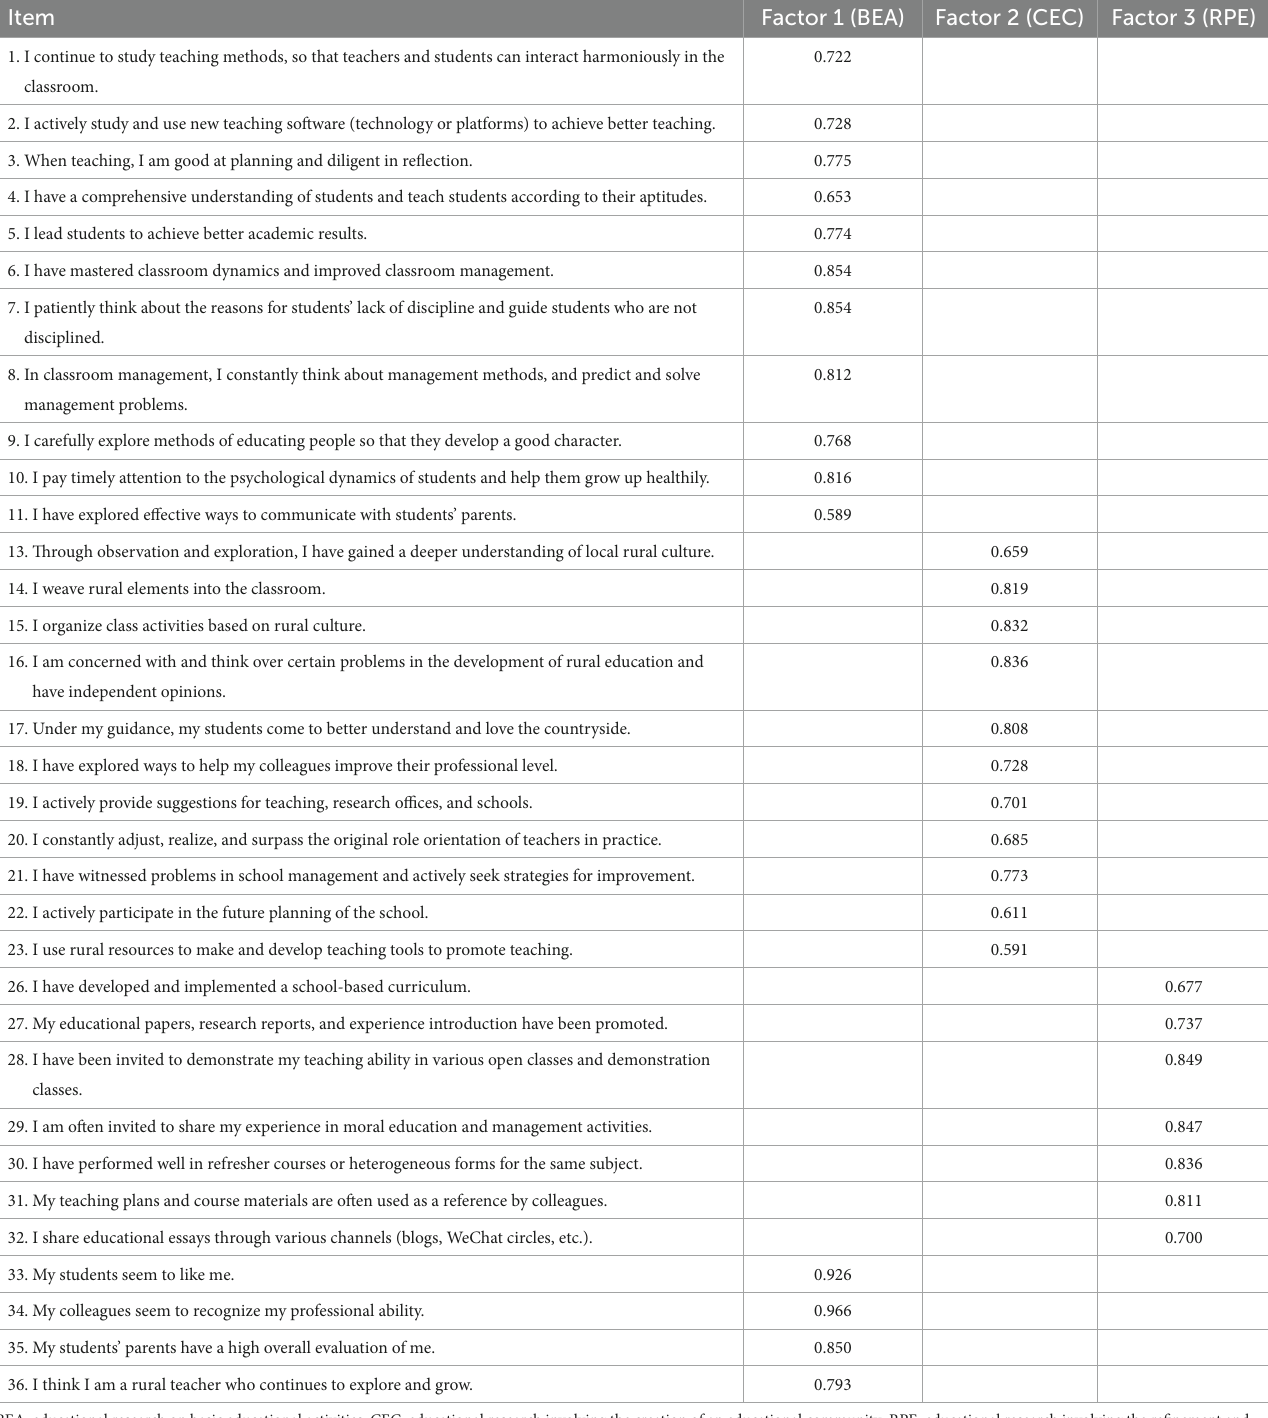
TABLE 1 Exploratory factor loadings for each item in Sample 1 ( N = 446).